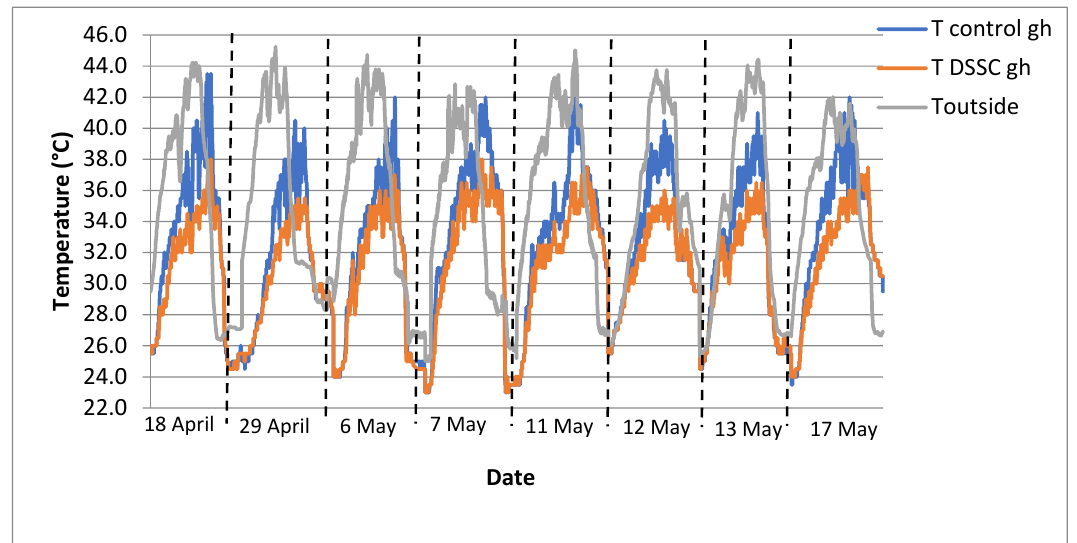
Figure 3. Air temperatures outside and inside greenhouses.